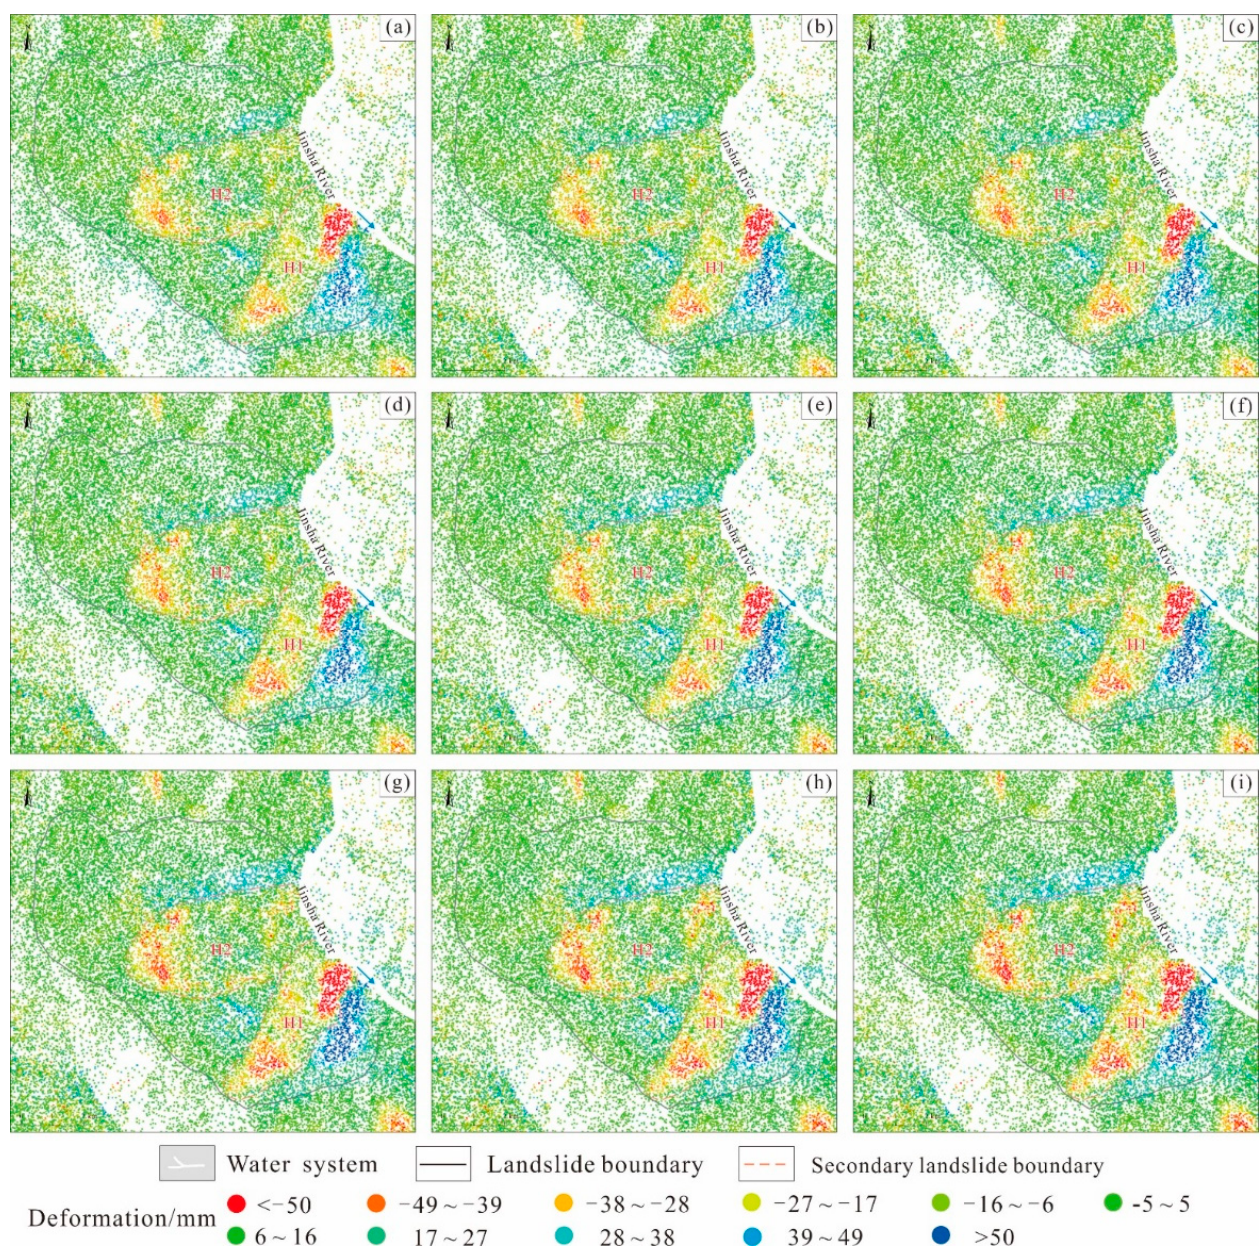
Figure 11. Deformation results of the Xiongba ancient landslide in different time periods (line-of-sight direction). Cumulative deformation time, ( a ) 28 August 2018; ( b ) 9 September 2018; ( c ) 21 September 2018; ( d ) 3 October 2018; ( e ) 15 October 2018; ( f ) 27 October 2018; ( g ) 8 November 2018; ( h ) 20 November 2018; ( i ) 26 December 2018. To quantitatively analyze the spatiotemporal deformation patterns and characteristics of the Xiongba ancient landslide, two typical profile lines, namely, A-A’ and B-B’, were selected on the slope body. The cumulative deformation curve diagrams were drawn by all the monitoring points (Figures 12 and